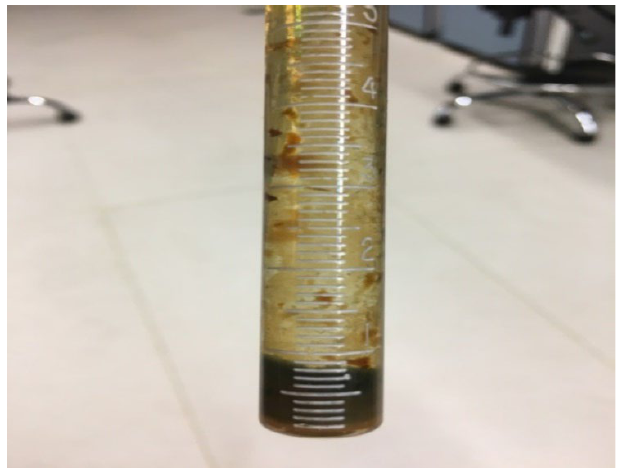
Figure 6. Observation of precipitation from the application of EK.